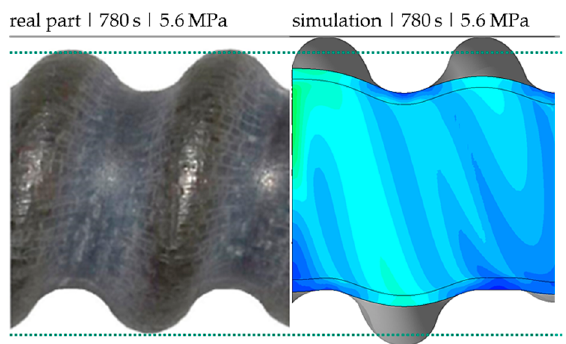
Figure 8. Comparison between the actual forming state of the experiments ( left ) with the forming stage of the simulation after 780 s ( right ).